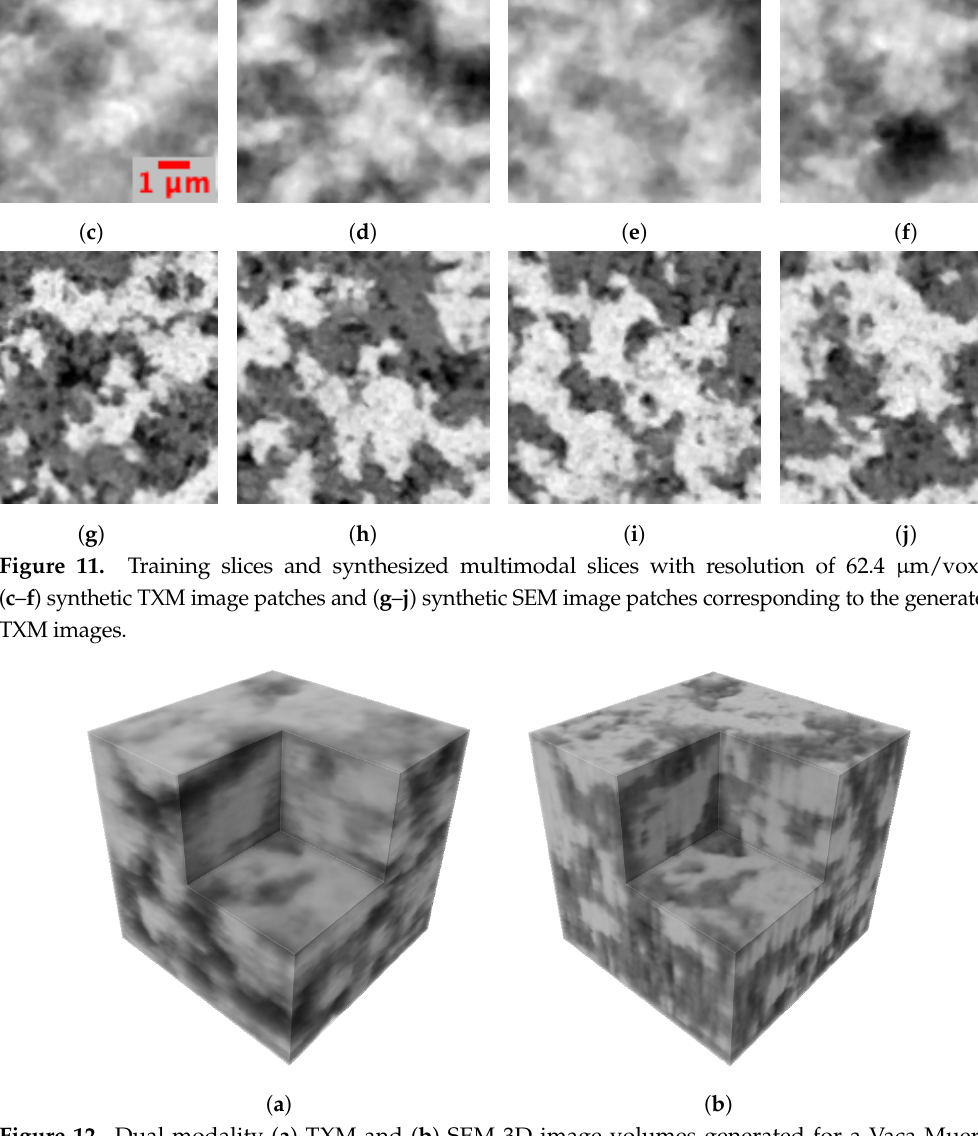
Figure 12. Dual-modality ( a ) TXM and ( b ) SEM 3D image volumes generated for a Vaca Muerta shale